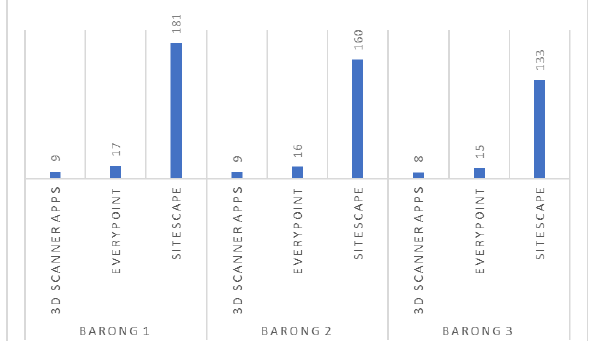
Figure 7 . Point density graph with a value of r = 1 cm using the nearest neighbor